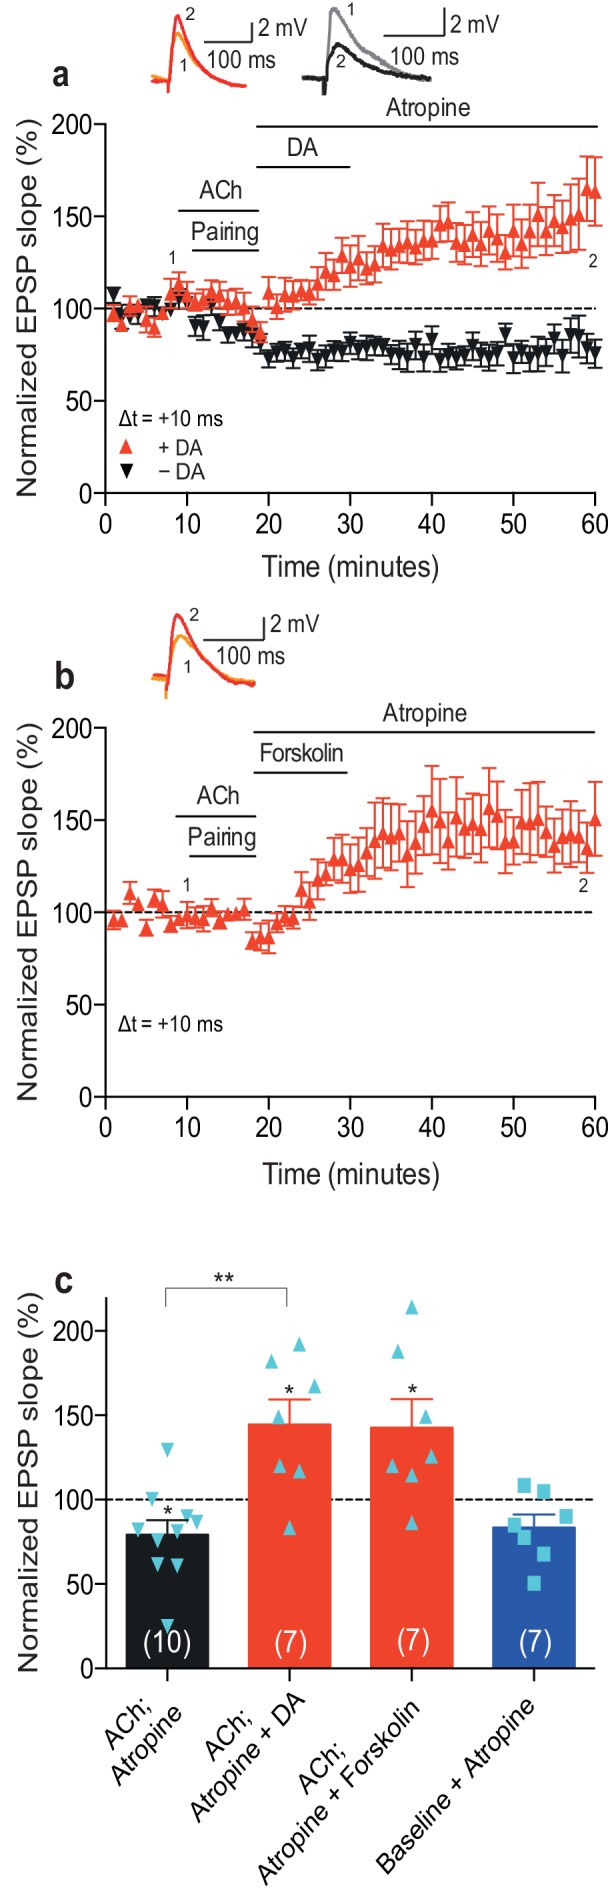
Dopamine retroactively converts acetylcholine-facilitated t-LTD into t-LTP.(a) Application of muscarinic acetylcholine receptor antagonist, 100 nM atropine, following acetylcholine (ACh; 1 μM) washout after the pre-before-post pairing protocol with Δt = +10 ms did not affect the development of ACh-facilitated t-LTD (black). Dopamine (DA; 100 μM) applied, together with atropine, immediately after ACh washout at the end of the same pairing protocol, converted ACh-facilitated t-LTD into t-LTP (red). Traces show an EPSP before (1) and 40 min after pairing (2) in the two conditions. (b) Forskolin (50 μM), applied together with atropine, converted ACh-facilitated t-LTD into t-LTP, mimicking the effect of DA. Traces are presented as in a. (c) Summary of results from a and b. In the absence of the pairing protocol, atropine had no significant effect on baseline EPSPs (blue). Error bars represent s.e.m. Significant difference (*p<0.05) compared with the baseline or between the indicated two groups (two-tailed Student’s t-test). The total numbers of individual cells (blue data points) are shown in parentheses.DOI:
http://dx.doi.org/10.7554/eLife.27756.00810.7554/eLife.27756.009Figure 2—source data 1.Source data for Figure 2.DOI:
http://dx.doi.org/10.7554/eLife.27756.00910.7554/eLife.27756.010Figure 2—source data 2.Source data for Figure 2—figure supplement 1.